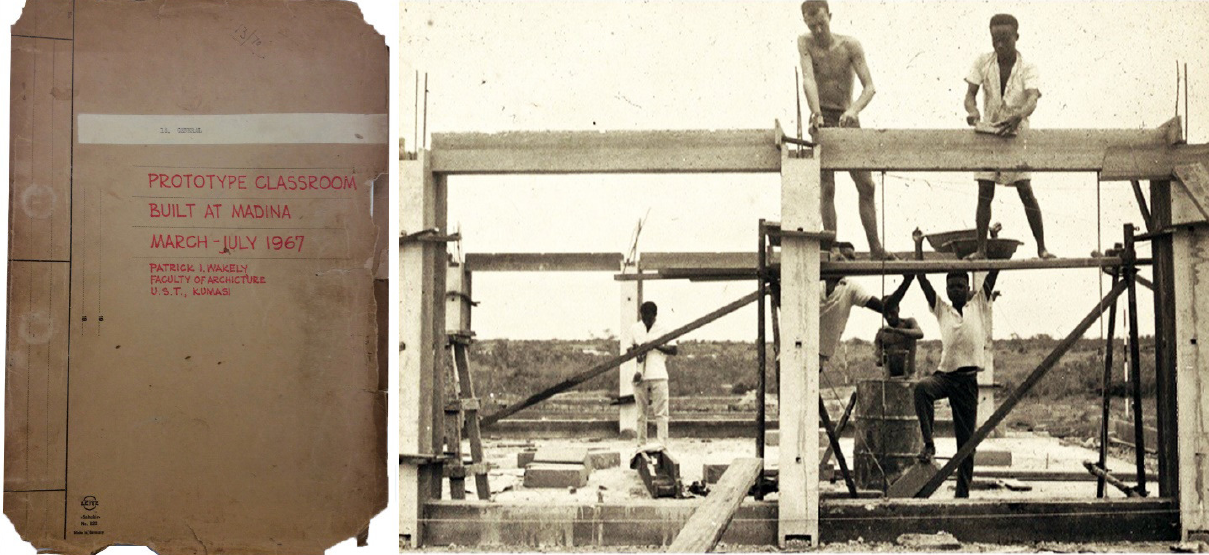
Figure 9. Patrick Wakely’s prototype of a classroom built at Madina and Ghana School Building prototype, 1967. Source: Wakely